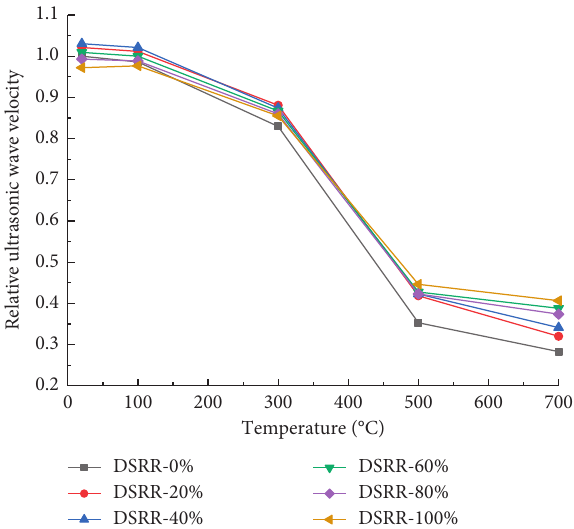
Figure 17: Relation between relative ultrasonic wave velocity and temperature.